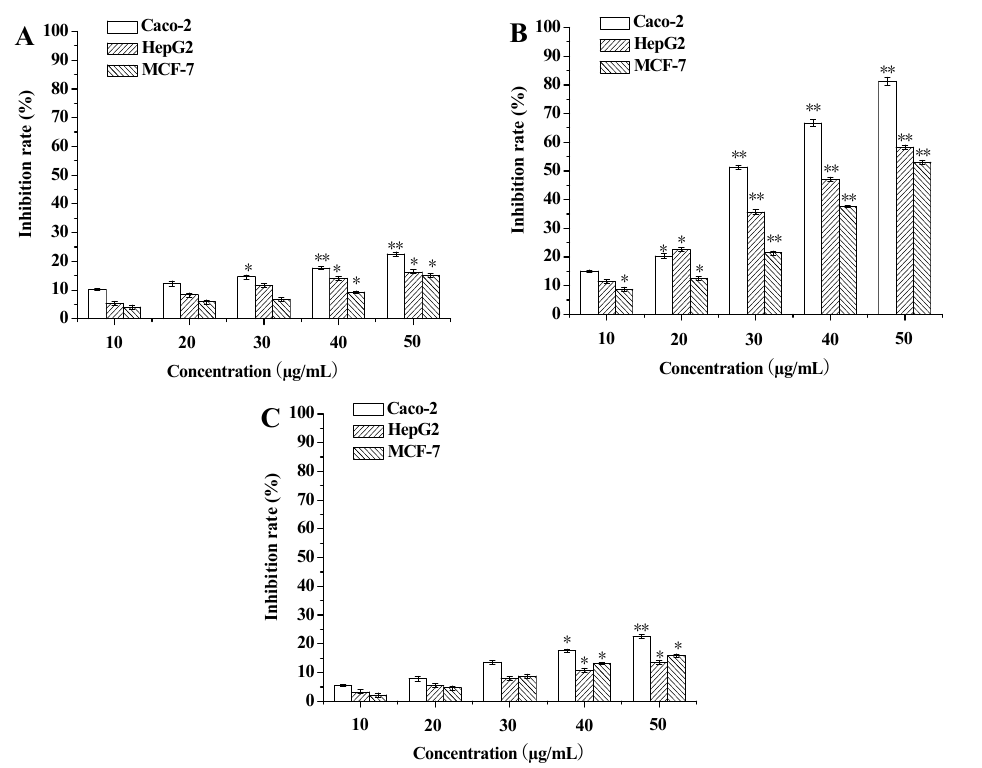
Figure 3. The cytotoxic effect of SBM extracts on three cancer cell lines. The cancer cells (Caco-2, HepG2 and MCF-7) were treated with various concentrations (0, 10, 20, 30, 40, 50 μ g/mL) of GA ( A ), CGC ( B ) and EP ( C ) for 72 h, respectively. GA: gallic acid, CGC: cyanidin-3- O -glucoside chloride, EP: epicatechin. All results are the means ± standard deviation (SD) ( n = 3). * p < 0.05 and ** p < 0.01, compared to the control group.